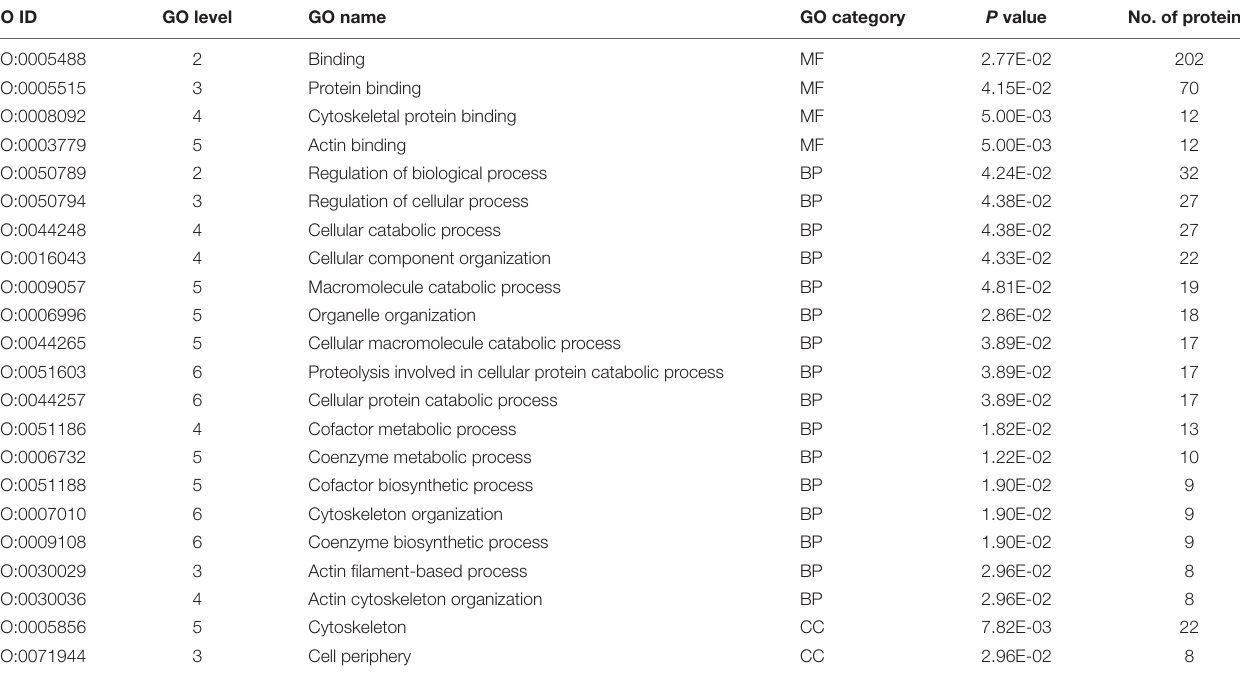
TABLE 2 | Gene ontology (GO) enrichment analysis of the 501 proteins increased in Bursaphelenchus xylophilus secretome under the Pinus pinea stimulus. GO ID GO